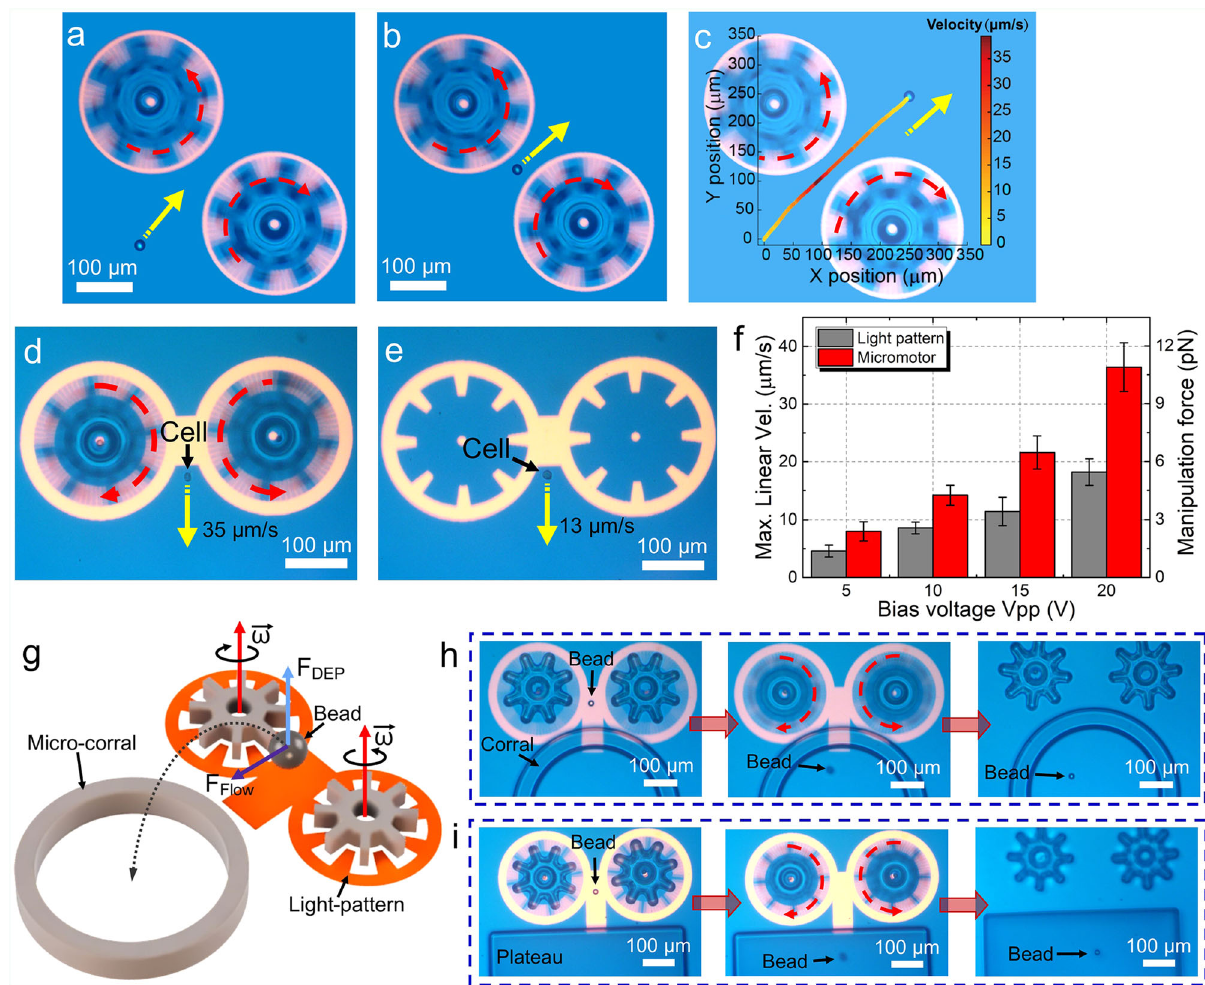
Fig. 4 Micromachine 1: the touchless micro-feed-roller. Frames from Supplementary Movie 9 at time a t = 0 s, b 12 s, and c 27 s, depicting the position of a 20- μ m-diameter polystyrene microbead propelled (with the direction indicated by yellow arrows) by a touchless micro-feed-roller. A plot of Cartesian coordinates of the bead from t = 0 to 27 s is superimposed on the image in ( c ), with bead velocity indicated in a heat map (yellow = stationary, red = 40 μ m/s). Frames from Supplementary Movie 10 depicting the translation of a B-16 cell translated at d 35 μ m/s by an OET-bridged touchless micro- feed-roller and e 13 μ m/s by the light pattern alone. f Plot of maximum translation velocity (left axis) and corresponding force (right axis) as a function of bias voltage for the manipulation of B-16 cells by OET-bridged touchless micro-feed-roller (red) and light pattern (OET) alone (gray). Error bars represent ±1 SD from fi ve measurements for each condition. g Schematic of an OET-bridged touchless micro-feed-roller used to cause a microbead to hop into a circular micro-corral. Frames from Supplementary Movie 11 illustrating the use of an OET-bridged touchless micro-feed-roller to cause a 15- μ m-diameter microbead to ( h ) hop into a circular micro-corral and ( i ) hop onto a micro-plateau. Dashed red lines with arrowheads indicate the direction of rotation of micromotors in relevant